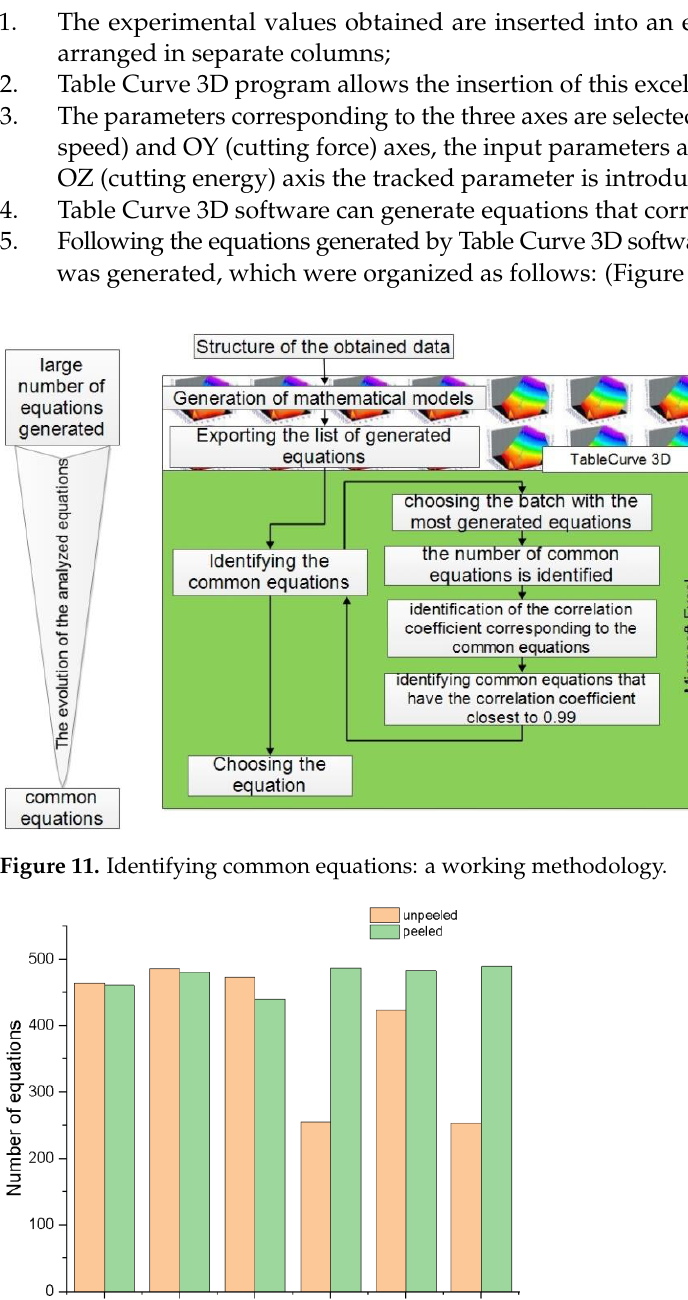
Figure 12. The number of equations generated by Table Curve 3d software varies according to the type of product under research.